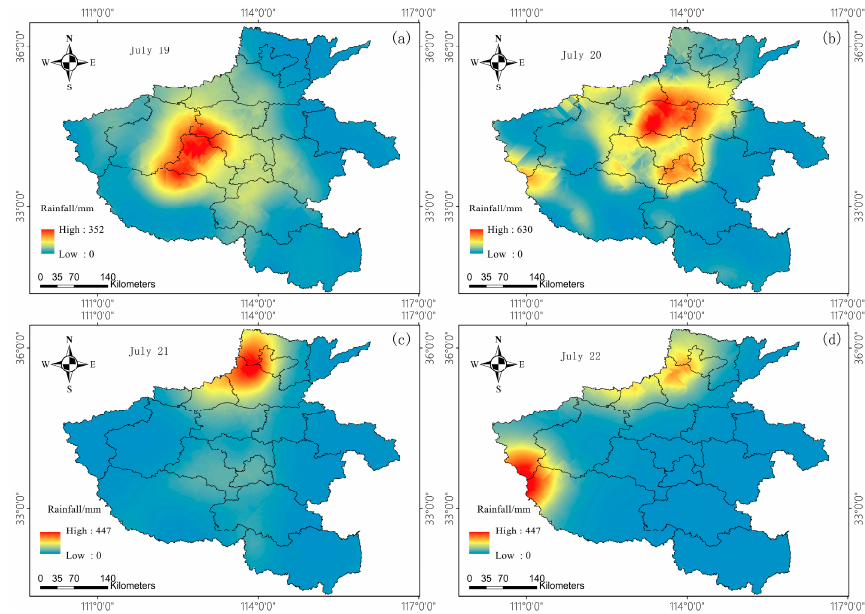
Figure 3. Distribution of rainfall in Henan Province from 19 July to 22 July: ( a ) Rainfall distribution on 19 July; ( b ) Rainfall distribution on 20 July; ( c ) Rainfall distribution on 21 July; ( d ) Rainfall distribution on 22 July.